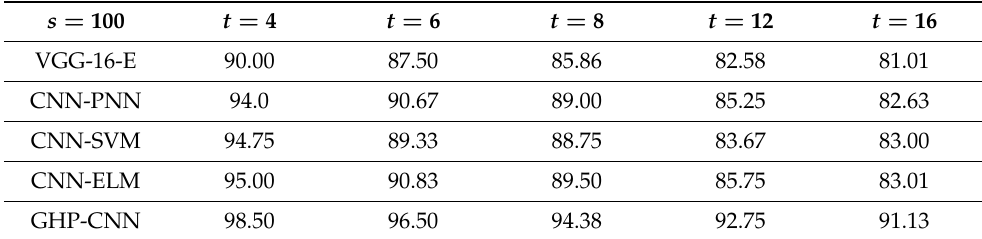
Table 2. Classification accuracy corresponding to different algorithms after category reduction with the CIFAR-100 dataset.